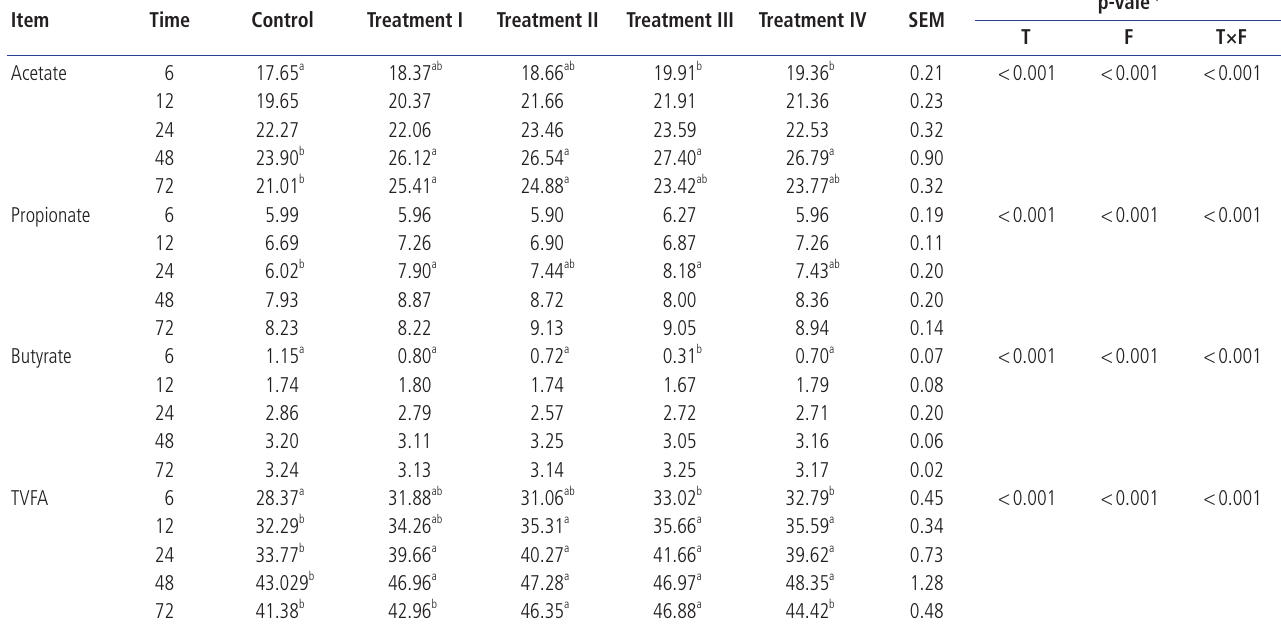
Table 6. Influence of zinc-bearing palygorskite on the production of VFA (mM/L) Item